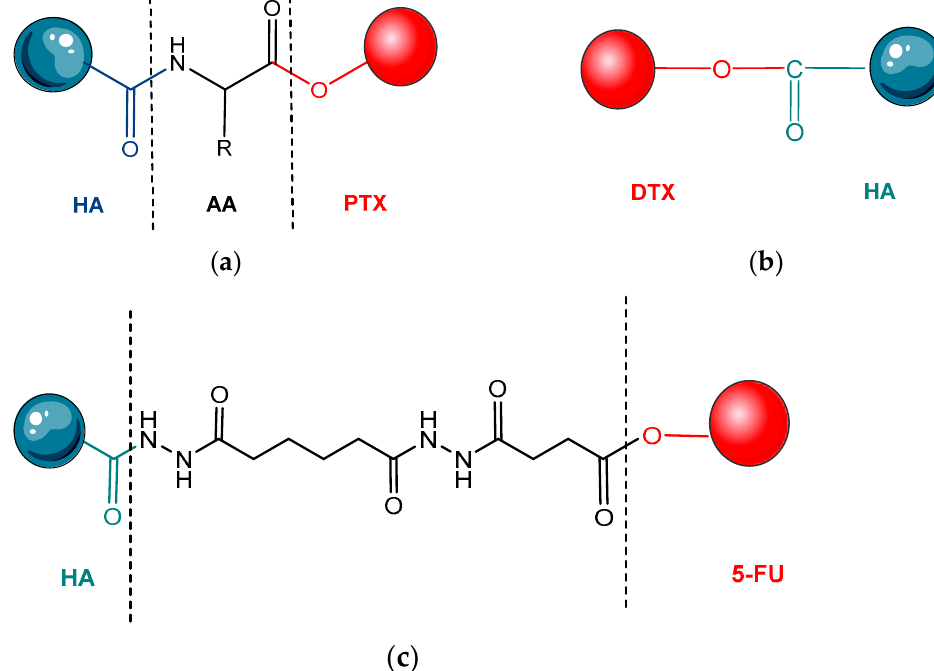
Figure 6. Drug–hyaluronic acid conjugates; ( a ) HA-amino acid-PTX conjugate [119]; ( b ) HA-DTX [125]; ( c ) HA-5-FU adapted after [129]. 5-FU—5-fluorouracil; AA—amino acid; DTX—docetaxel; HA—hyaluronic acid; PTX—paclitaxel.